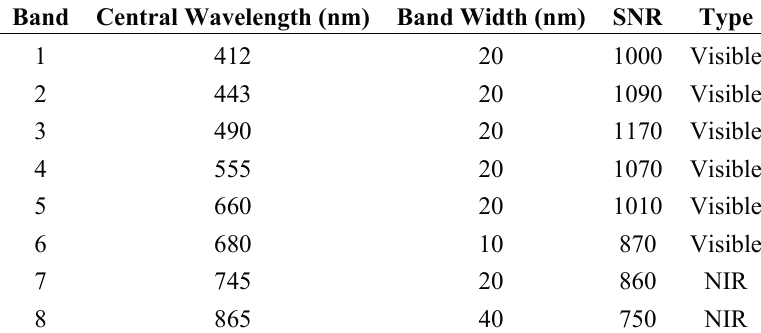
Table 1. Spectral bands of GOCI